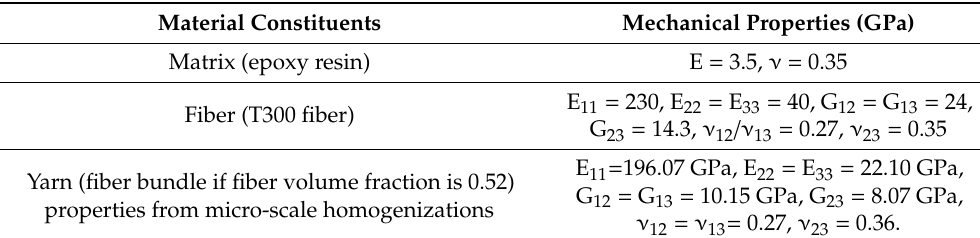
Table 1. Calculated mechanical properties of the constituents (matrix and fibers) and composites (micro-scale).